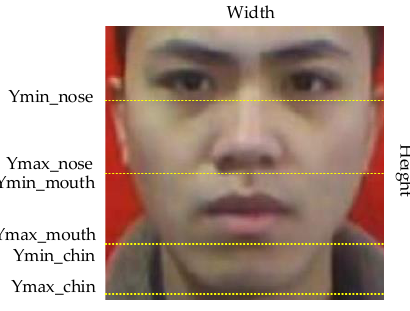
Figure 10. Division of key parts.